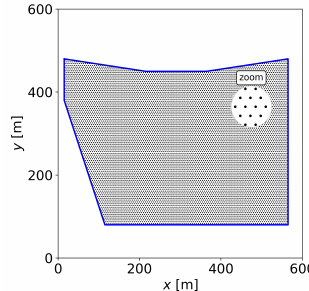
Figure 3. Mesh for the bathymetry. The bathymetry domain is shown in